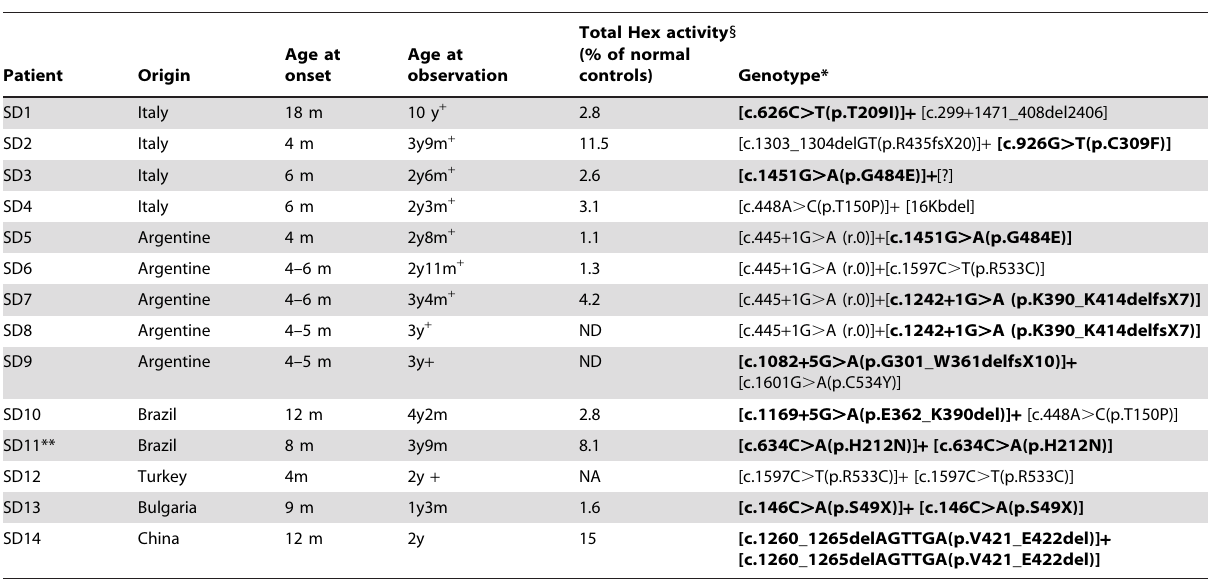
Table 1. Genotypes of SD patients analyzed in this